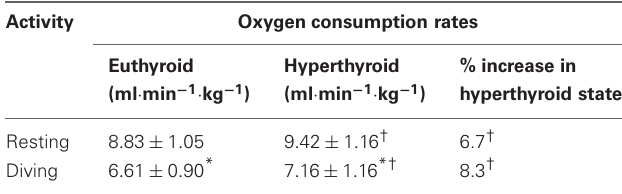
Table 1 | Oxygen consumption rates (s ˙ Vo 2 ) in the euthyroid and hyperthyroid state.